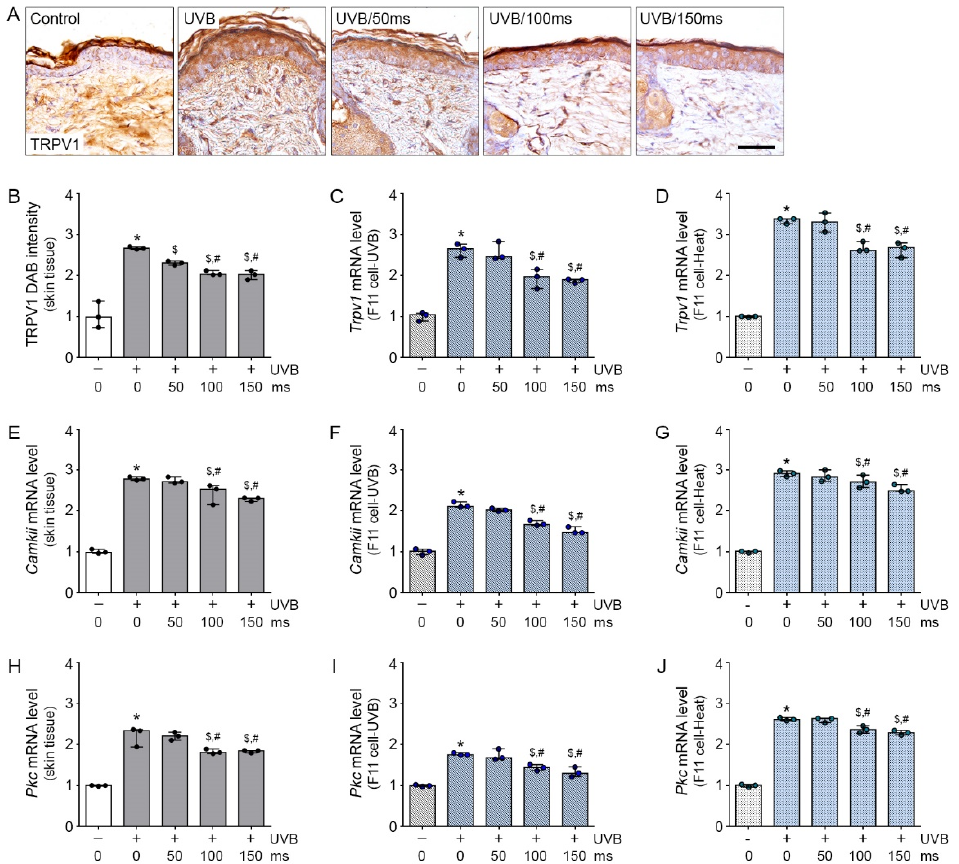
Figure 1. Inhibitory effects of RF on TRPV1 and PKC - dependent pathway in UVB - exposed mice skin and UVB - or heat - treated sensory neuronal cells. ( A , B ) TRPV1 expression level was analyzed by immunohistochemistry (3 mice per group). Scale bar = 100 µm; ( B – J ) Expression of the TRPV1 related PKC - dependent pathway molecule, CAMKII and PKC mRNA were confirmed by qRT-PCR in the skin tissue ( B , E , H ), UVB exposure F11 cell model ( C , F , I ) and heat exposure F11 cell model ( D , G,J ) and were normalized to that of Actb and expressed relative to the control group. * p < 0.05 vs. Control; $ p < 0.05 vs. UVB or Heat; # p < 0.05 vs. RF 50 ms.